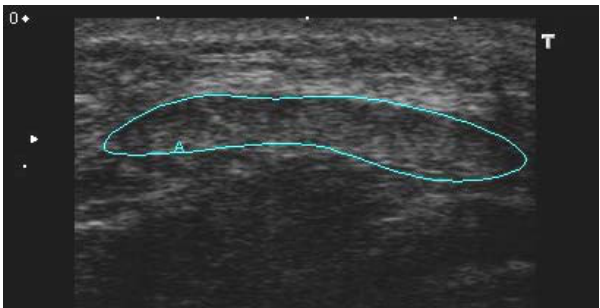
Fig. 3 Typical ultrasound image of the proximal cross-section of the patellar